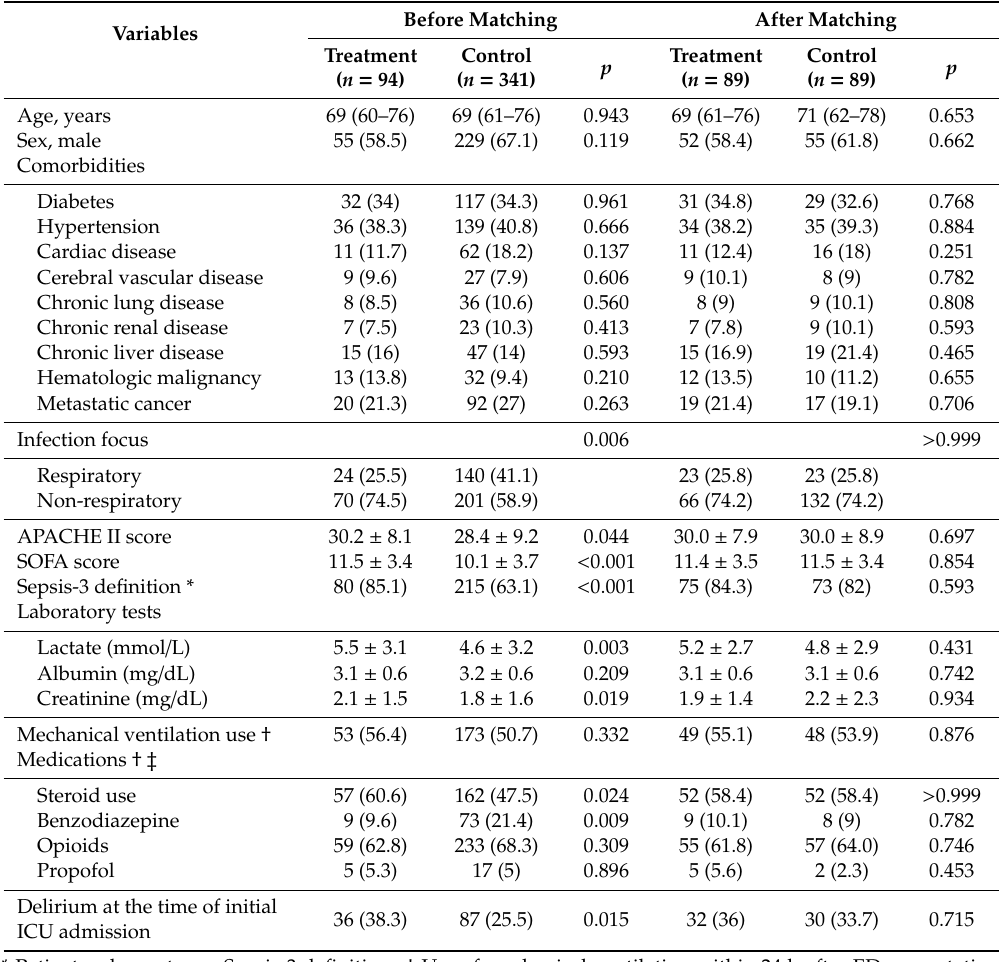
Table 1. Baseline characteristics of the overall and matched cohorts.